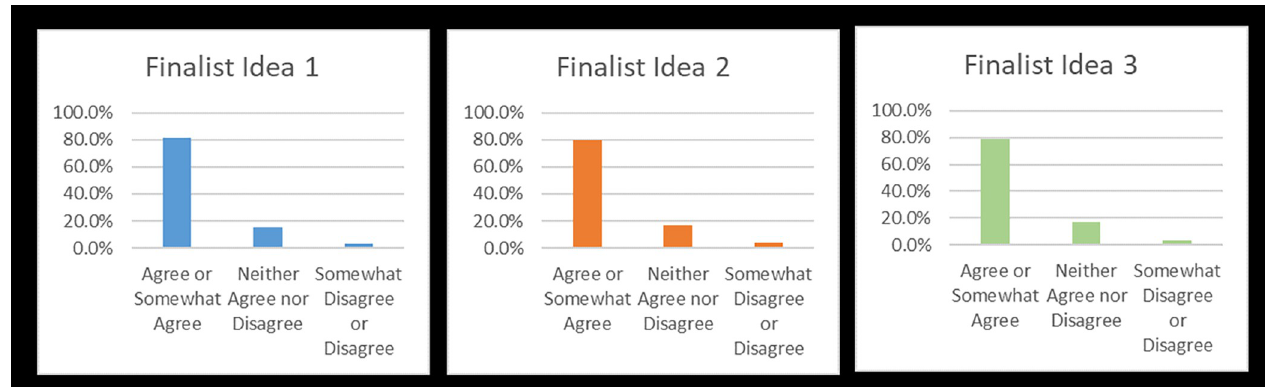
Fig 2. Survey participants’ responses to the statement “In the context of COVID-19 safety measures (i.e. physical distancing), this idea would make UNC a safer place”, by finalist idea (1, 2 and 3) (N = 437).